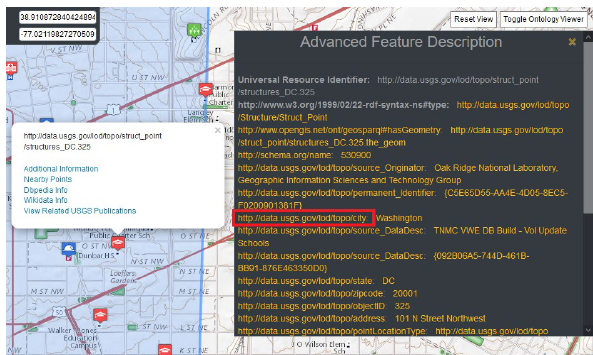
Figure 3. Properties available for selected feature-level data by browsing the graph. Links to additional information from Linked Open Data (LOD) and related USGS publications are shown on the left.